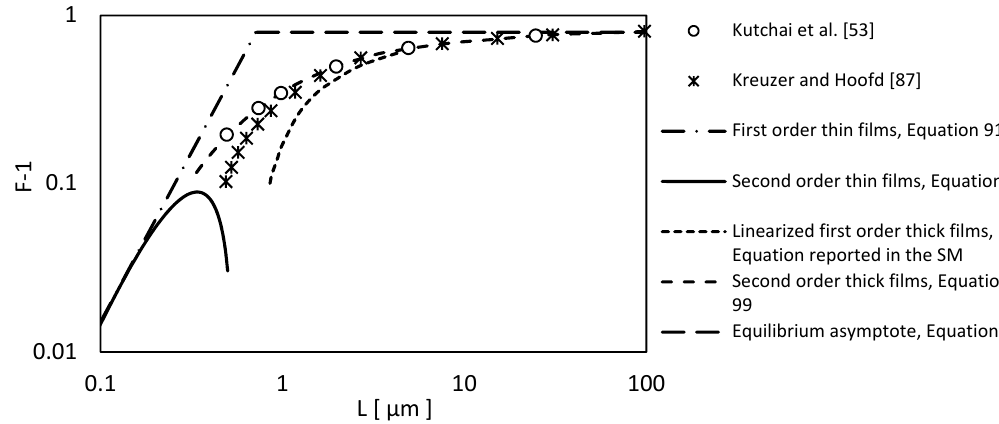
Figure 4. Reactive contribution to facilitation factor as function of membrane thickness.